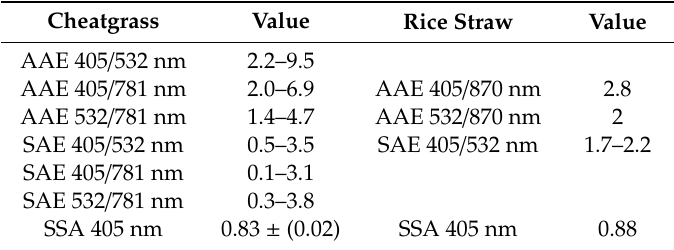
Table 2. The optical properties absorption Ångström exponent (AAE), the scattering Ångström exponent (SAE), and the single scattering albedo (SSA) of cheatgrass combustion emissions are listed, along with the optical properties (i.e., AAE, SAE, and SSA) of rice straw combustion emissions, as reported by Lewis et al.